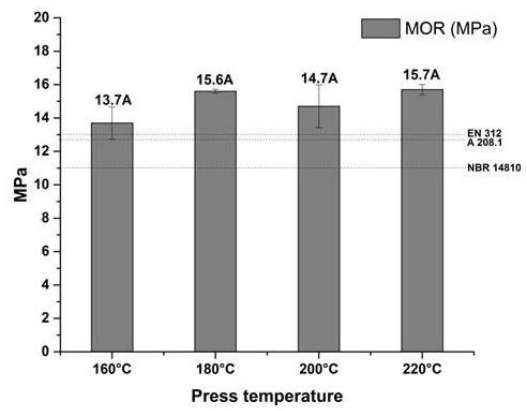
Figure 5. Modulus of rupture (MOR) for particleboard panels produced with sugarcane bagasse and plastic bag particles at different pressing temperatures. * Averages followed by similar letter did not differ statistically by the Scott-Knott test at 5% significance level.